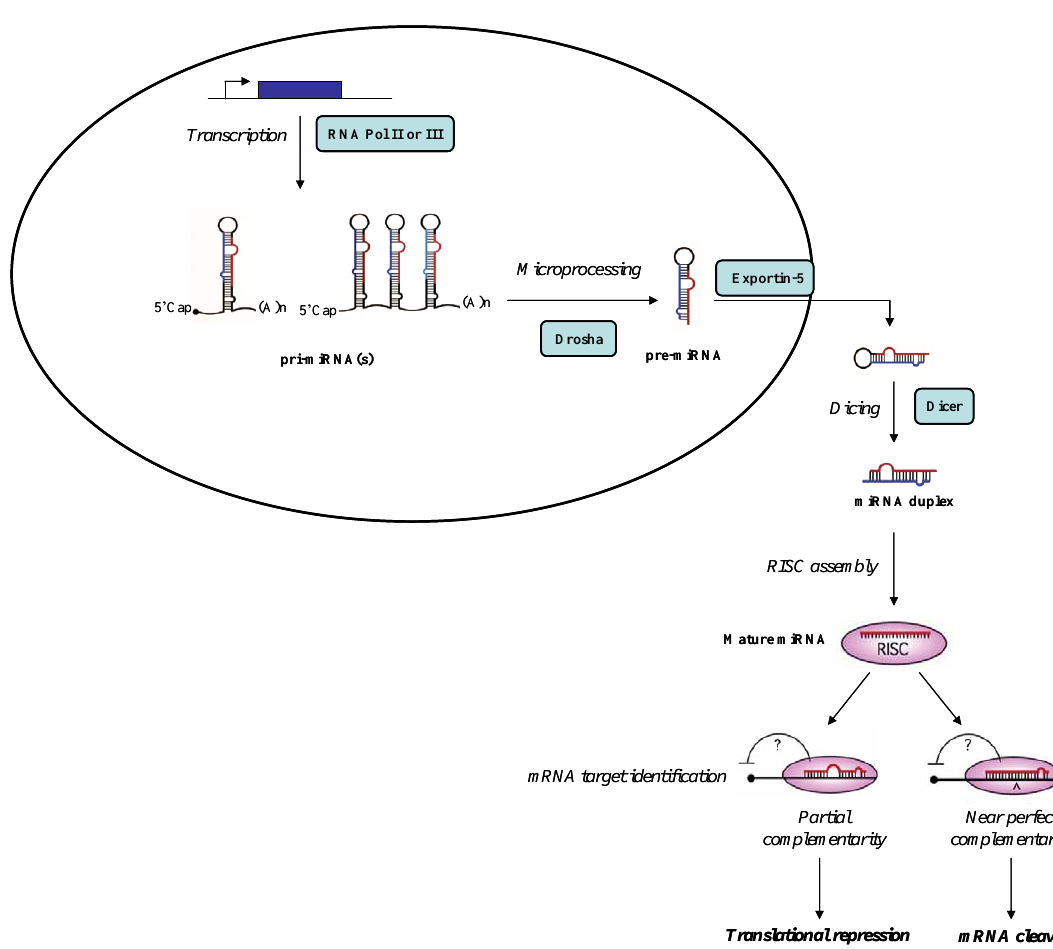
Figure 1. Scheme of miRNA processing